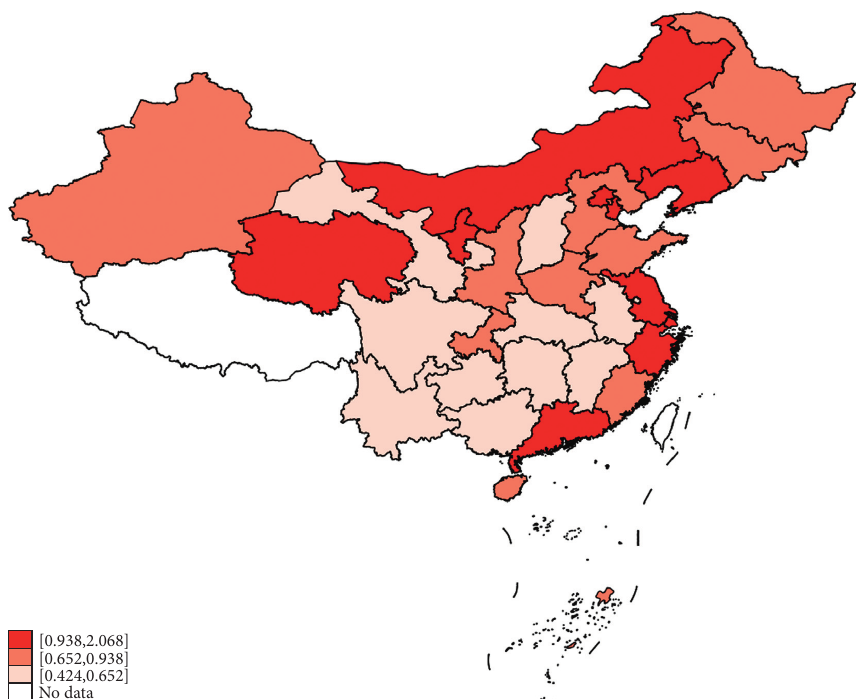
Figure 1: Spatial distribution of provincial SE financial efficiency using the three-stage SE-DEA